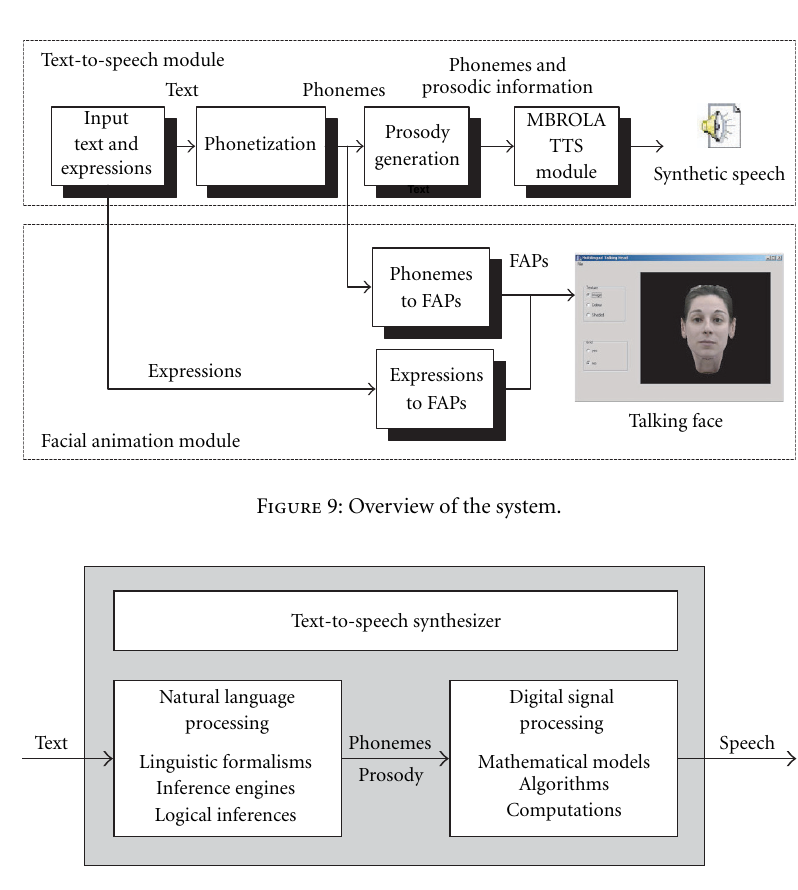
Figure 10: General overview of a TTS synthesizer